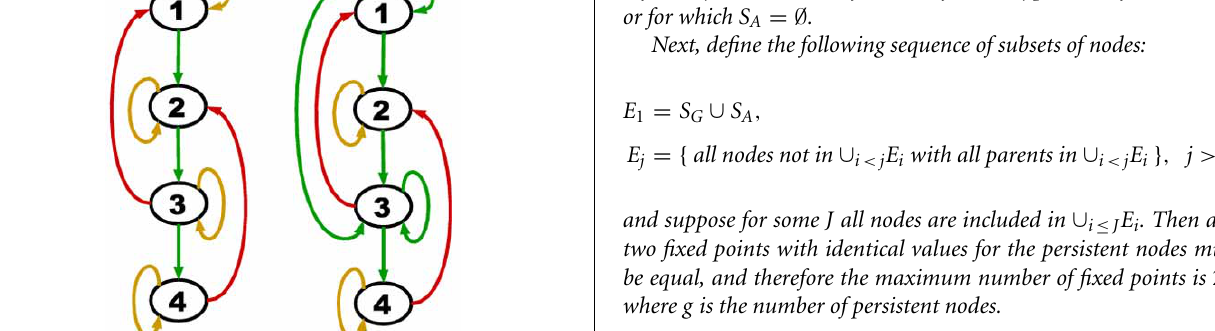
green self loop. Theorem 1 concerns the special case in which all genes are assigned yellow loops. A green self loop is formally a cycle (which does not contain a red edge), and so the hypoth- esis of Theorem 1 does not hold if any persistent nodes are